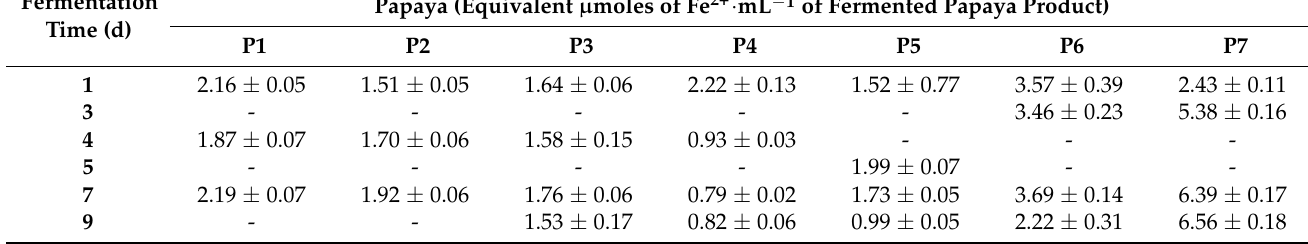
Table 4. Changes in total antioxidant activity (FRAP method) of the fermented papaya samples during fermentation assays (P1 to